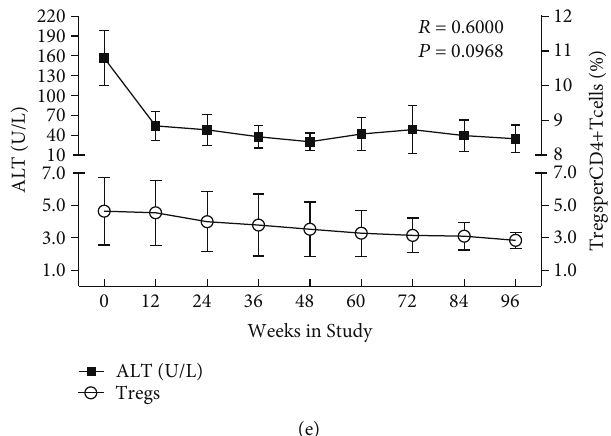
Figure 2: Association between the ALT levels and the Treg frequencies in HBeAg seroconverting (SC) and non-SC subjects during TDF treatment. (a) Peripheral CD4+CD25+ Treg frequencies in HBeAg SC, non-SC subjects, and healthy control (HC). Data are expressed as a scatter diagram in which the midpoint of the black solid line is the mean of Treg frequencies (Treg per CD4+ T cells, %), and the upper and lower horizontal lines represent the standard deviation (SD). The P values of multiple comparisons were calculated using the Kruskal – Wallis H nonparametric test. (b) Representative scatter plots were obtained by fl ow cytometry labeled antibodies against CD4 and CD25. The number of CD4+CD25high (CD4+CD25high+) Treg cells per CD4+ T cells was evaluated ( fl uorescence intensity of CD 25 > 50 ). (c) Longitudinal changes of CD4+CD25+ Treg percentages in HBeAg SC and non-SC subjects during TDF treatment. ∗ P < 0 : 05 and ∗∗ P < 0 : 01 when comparing to those in SC or non-SC subjects at baseline, respectively. # P < 0 : 05 and ## P < 0 : 01 when comparing the Treg percentages between the HBeAg SC and non-SC subjects at the same treatment time point using nonparametric tests. Association is between the ALT levels and Treg percentages in HBeAg SC (d) and non-SC (e) subjects. The x -axis indicates the di ff erent treatment time points; (d) and (e) on the left y -axis show the ALT levels, and the right y -axis shows the Tregs per CD4+ T cells (%). Correlations were analyzed using a Spearman correlation